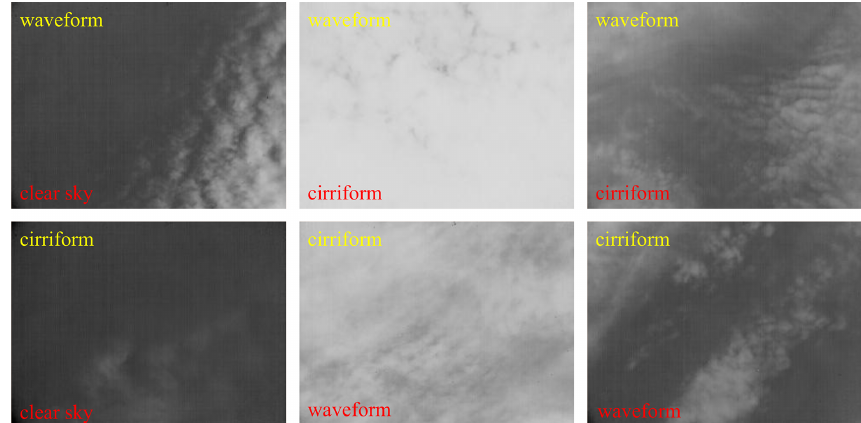
Figure 10. Misclassified images of the zenithal dataset. The yellow labels are the ground truth, and red labels are predicted cloud types. Waveform clouds and cirriform clouds are categorized as clear sky because the size of sky area is much larger than that of clouds, and these two cloud types are easily confused as they share similar local patterns.